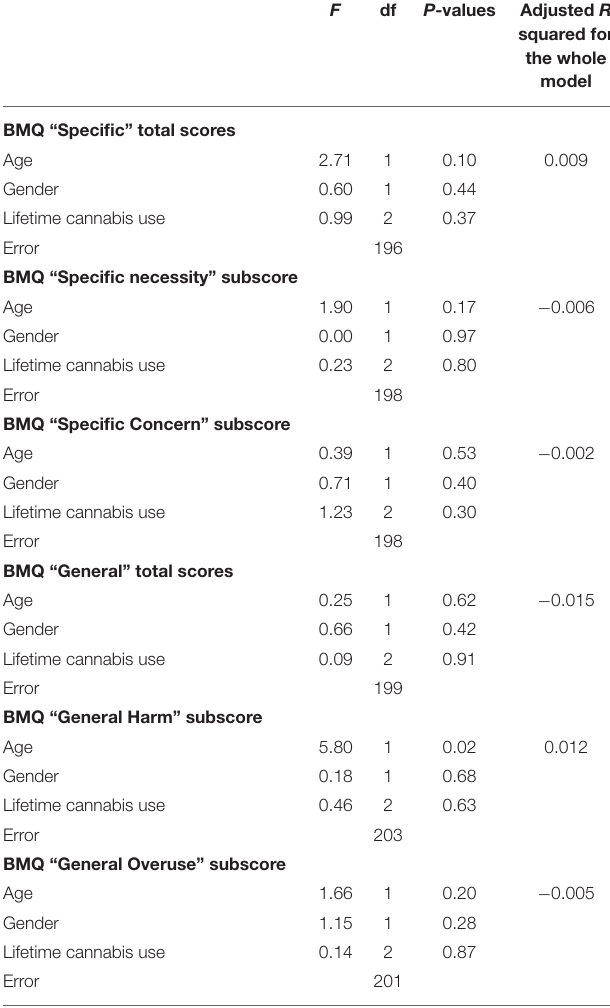
TABLE 4 | General linear model (GLM) analyses examining the relationship between lifetime cannabis use and beliefs about medication (BMQ) in patients with